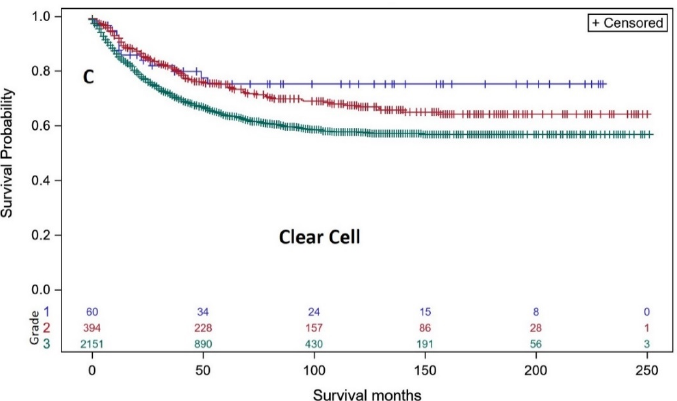
Figure 2. Kaplan–Meier ovarian cancer-specific survival showing number of women at risk according to grade of endometrioid EOC, mucinous carcinoma and clear cell EOC. ( A ). Women with endometrioid EOC (8380 / 3) that was grade 1 well di ff erentiated (blue curve, n = 1982; 50, 100 & 200-month survival is 94.8%, 91.4%, 86.5%), grade 2 moderately di ff erentiated (red curve, n = 2761; 50, 100 & 200-month survival is 84.3%, 77.1%, 71.7%), and grade 3 undi ff erentiated (green curve, n = 2169; 50, 100 & 200-month survival is 66.4%, 52.9%, 44.4%). Log-rank test p < 0.001. ( B ). Women with mucinous EOC (8470 / 3, 8471 / 3, 8480 / 3, 8481 / 3, 8482 / 3) that was grade 1 well di ff erentiated (blue curve, n = 1506; 50, 100 & 200-month survival is 84.5%, 80.7%, 76.4%, grade 2 moderately di ff erentiated (red curve, n = 1431; 50, 100 & 200-month survival is 72.1%, 67.7%, 65.8%), and grade 3 undi ff erentiated (green curve, n = 699; 50, 100 & 200-month survival is 46.5%, 39.7%, 35.2%). Log-rank test p < 0.001. ( C ). Women with clear cell EOC (8310 / 3) that was grade 1 well di ff erentiated (blue curve, n = 60; 50, 100 & 200-month survival is 77.4%, 74.7%, 74.7%), grade 2 moderately di ff erentiated (red curve, n = 394; 50, 100 & 200-month survival is 76.2%, 69.0%, 63.3%), and grade 3 undi ff erentiated (green curve, n = 2151; 50, 100 & 200-month survival is 67.1%, 58.6%, 56.3%). The number of women remaining at di ff erent survival points is shown for well di ff erentiated screened (blue), moderately di ff erentiated (red), undi ff erentiated (green). Log-rank test p < 0.001.